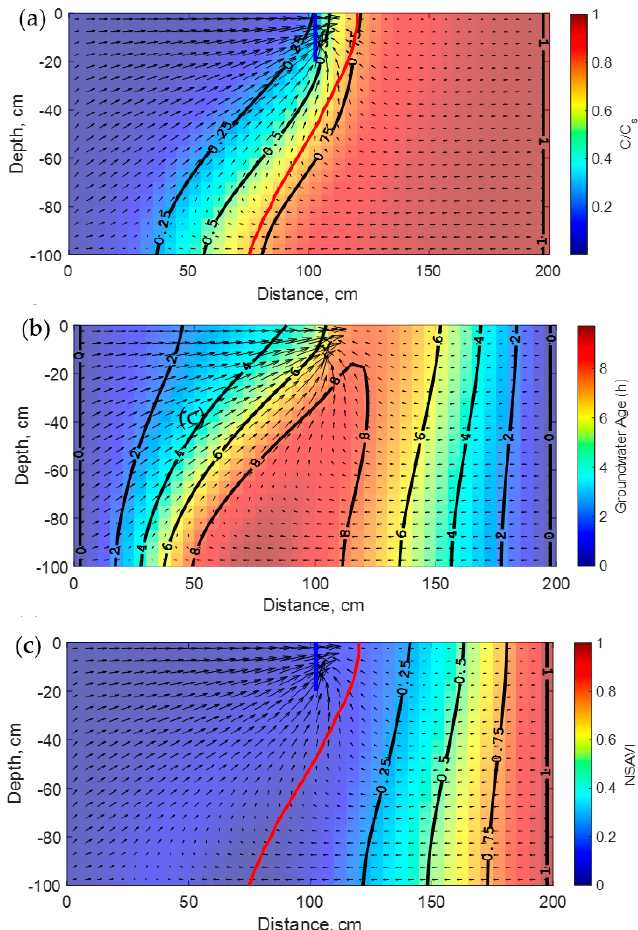
Figure 4. Spatial distribution patterns of ( a ) the steady-state concentration isochlors, ( b ) the direct mean groundwater age, and ( c ) the vulnerability index to seawater intrusion for the modified Henry problem with a partially penetrating pumping well (blue line) discharging 10 − 4 m 3 .s − 1 . The zero-vulnerability line (ZVL) is plotted with red color.